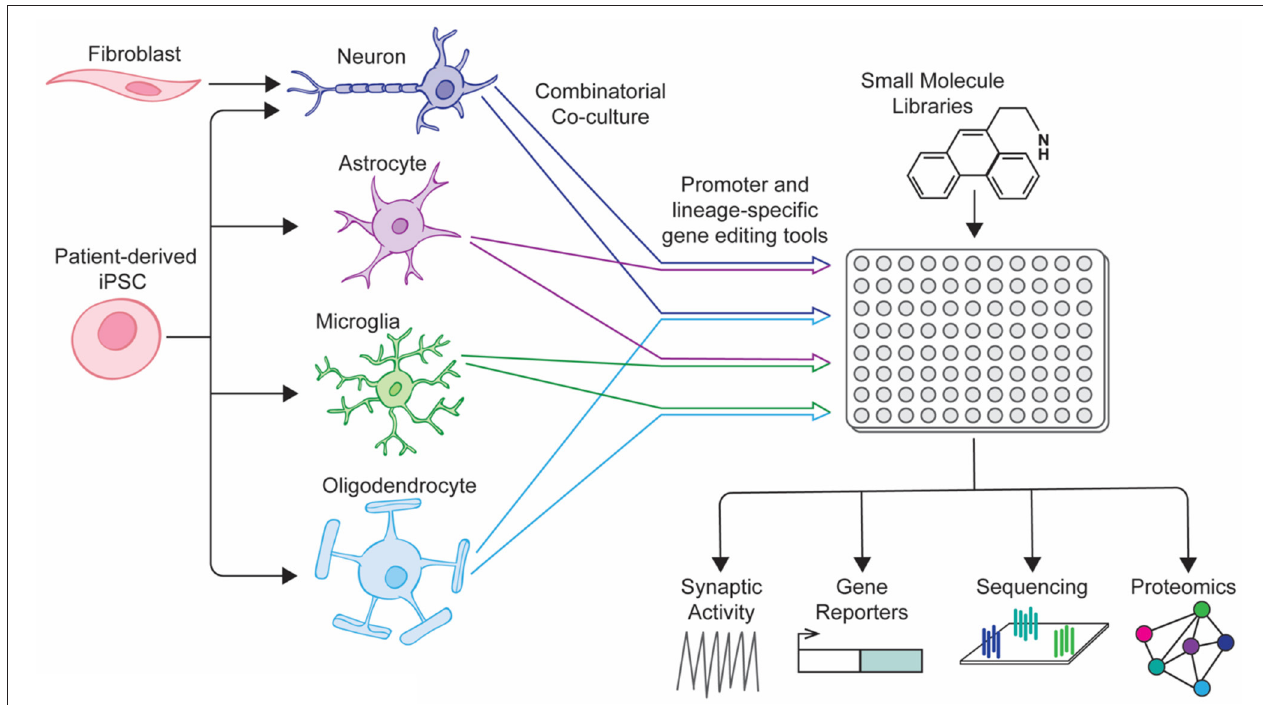
FIGURE 1 | Next-generation drug screening platform for neuropsychiatric disorders. Directed differentiation and reprogramming of patient-specific cell types into various neural cell types allows for combination culture of cell types of interest. When combined with lineage-specific reporter systems, mixed neural cultures could be screened using small-molecule libraries and the results of downstream assays correlated with the cell-type of interest.